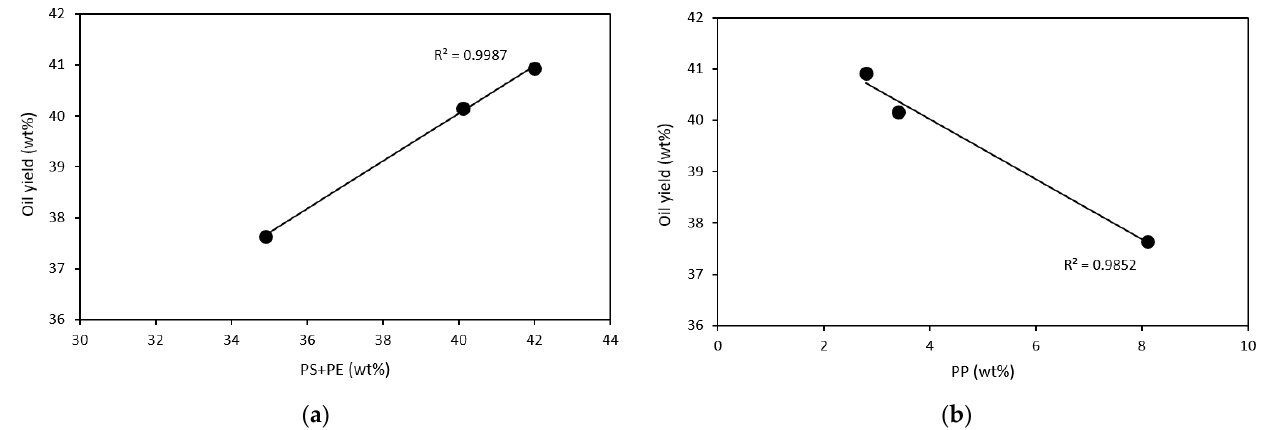
Figure 4. Relationship between plastic waste and oil yield: ( a ) relationship between PS + PE and oil yield; ( b ) relationship between PP and oil yield.